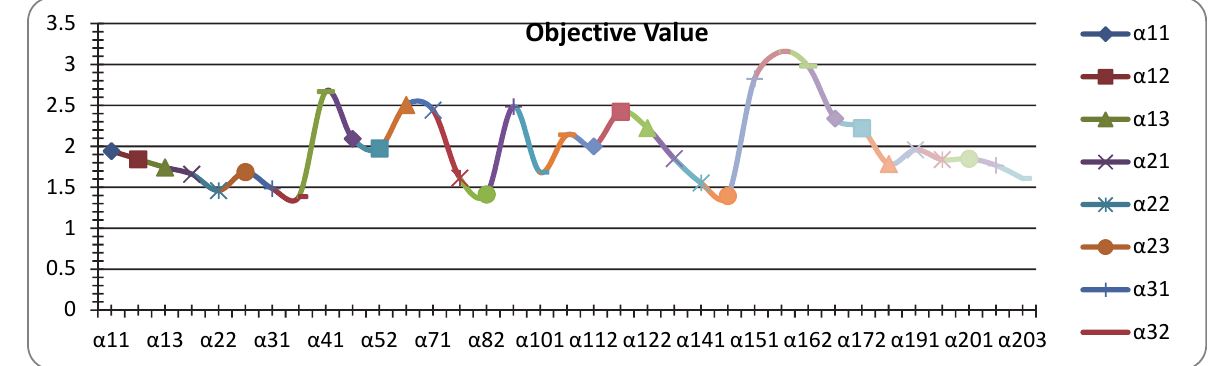
Fig. 5. Objective coefficients for problem with more